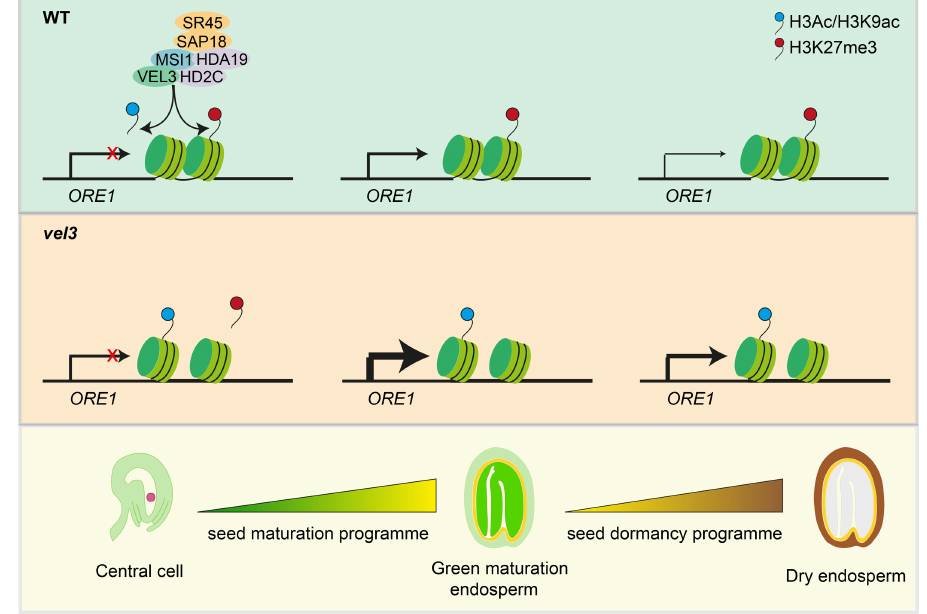
Fig. 8 | VEL3 associates with the HDAC complex and possibly also PRC2 in the female gametophyte to establish a maternal repressive epigenetic state on dormancy-associated genes (e.g., ORE1). The distribution of H3K27me3 is stable and determines the expression level of targeted genes once they are activated